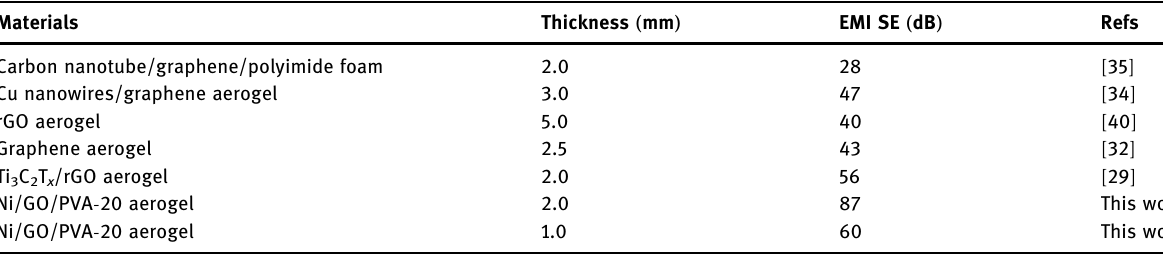
Table 1: Comparison of EMI shielding properties of related materials in literature Materials Carbon nanotube/graphene/polyimide